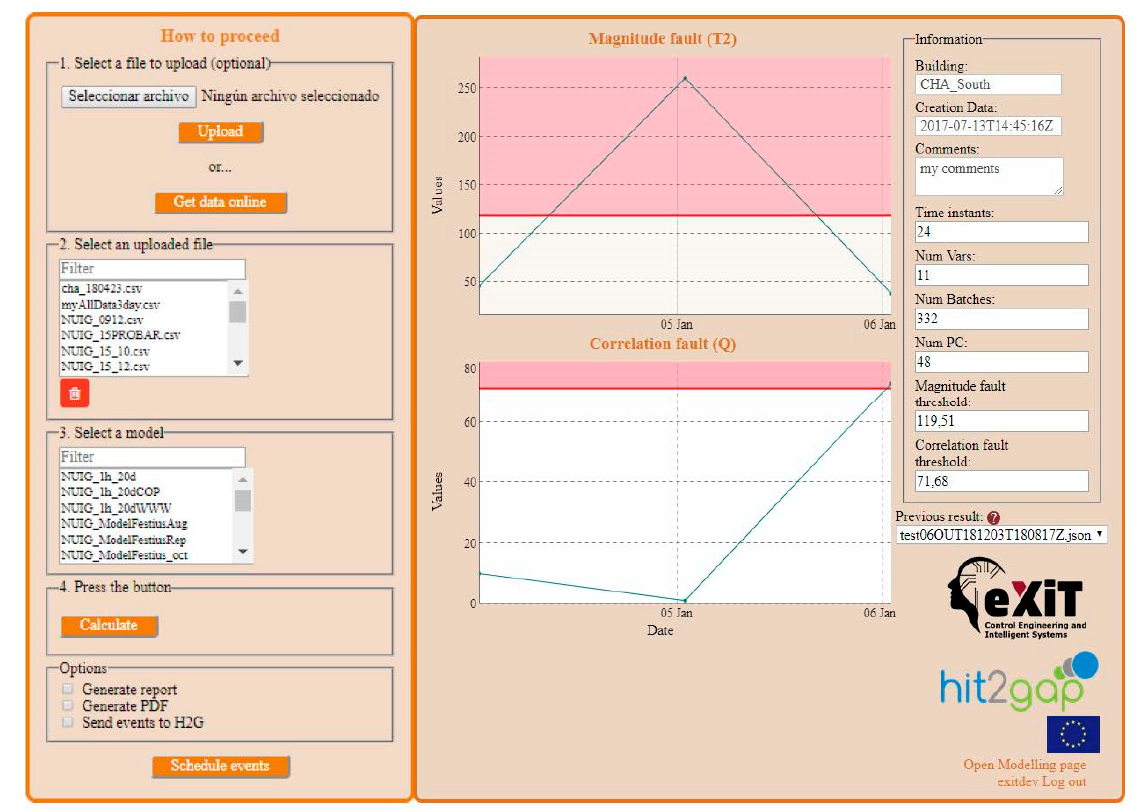
Figure 3. Monitoring interface.